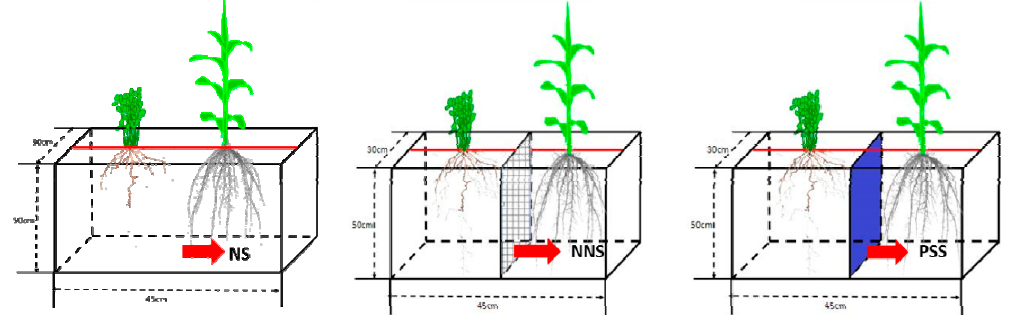
Figure 1. Schematic diagram of the maize/alfalfa intercropping pot experiment. NS represents no root separation between the maize and alfalfa, NNS and PSS represent maize and alfalfa root separation with a nylon net barrier and a plastic sheet barrier, respectively.